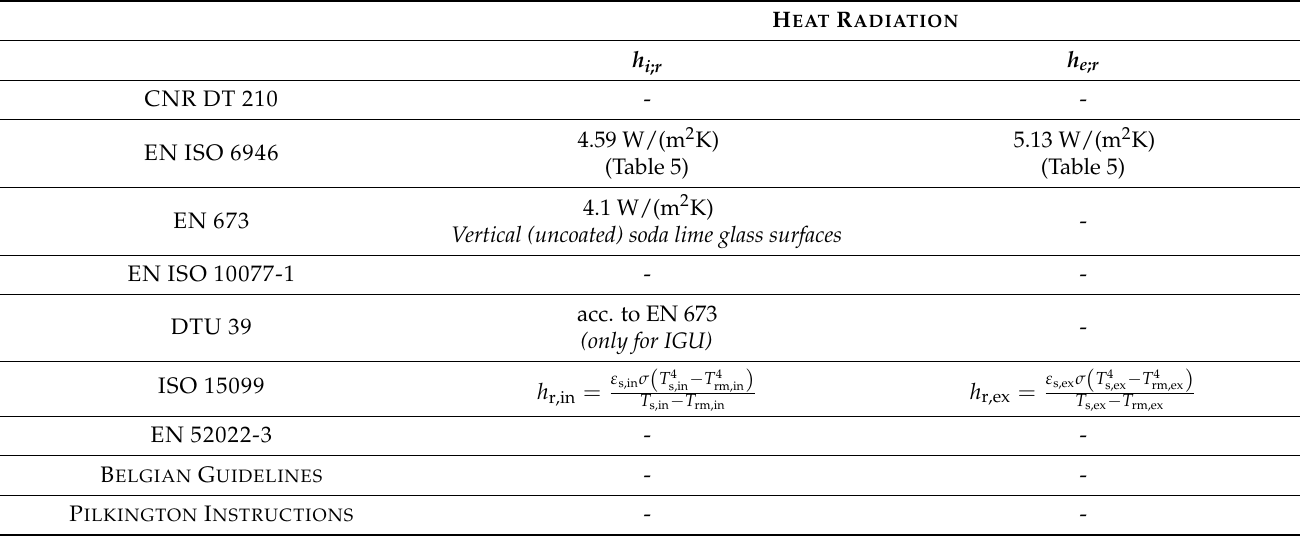
Table 1. Heat radiation contributions according to different